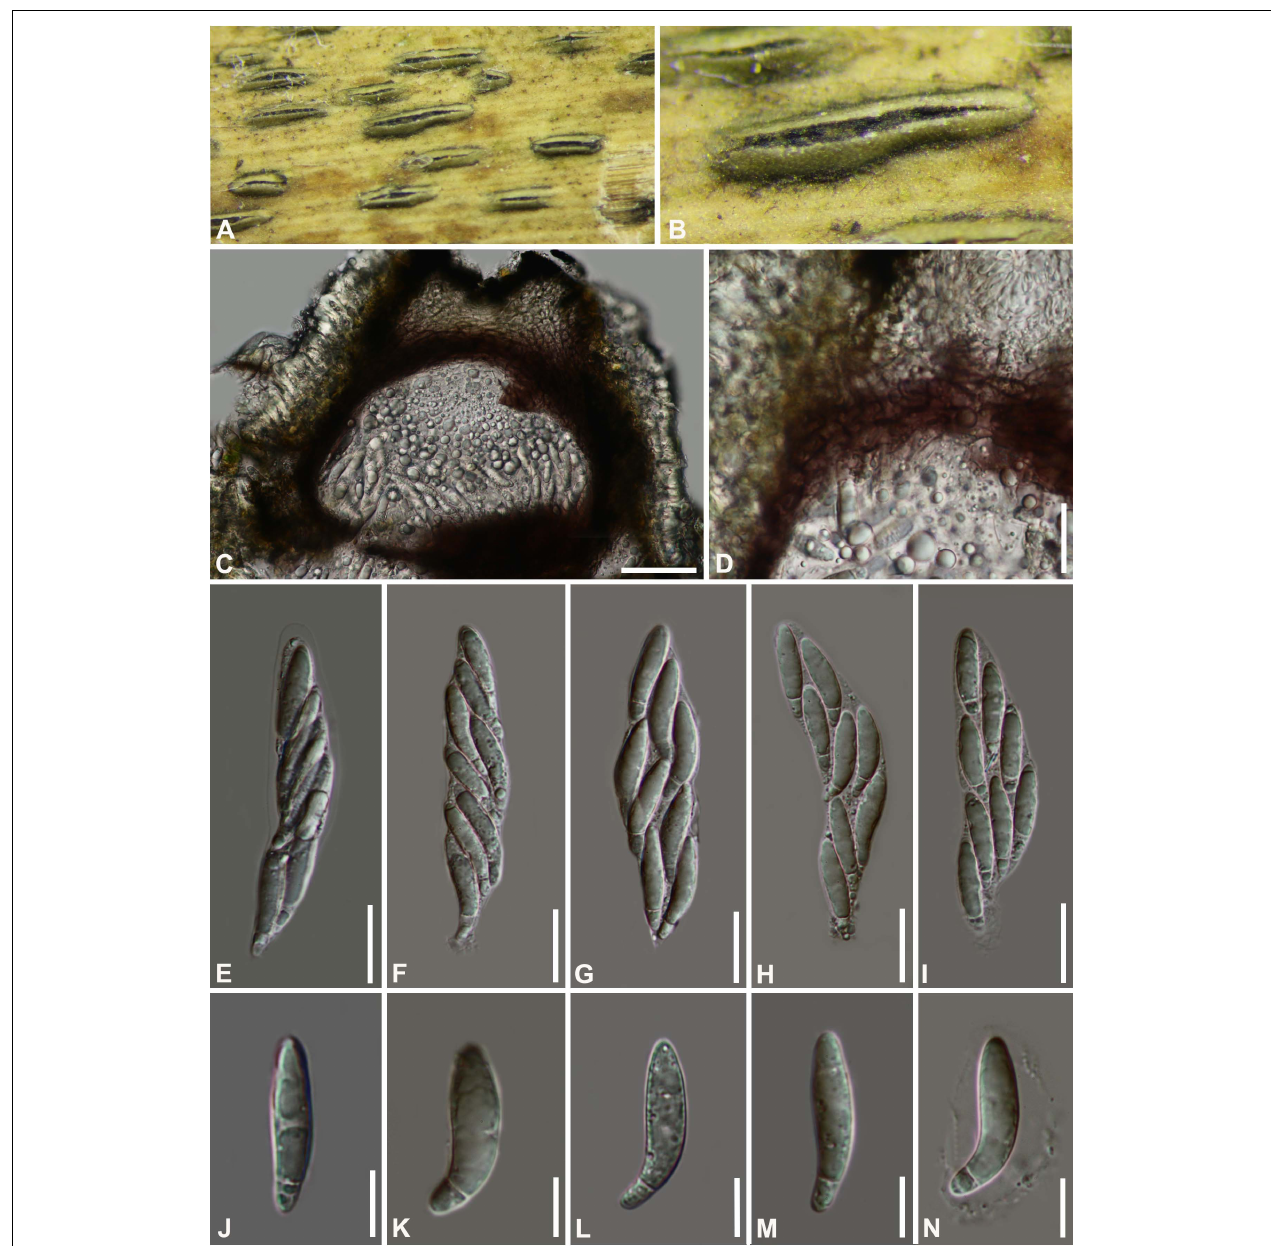
FIGURE 3 | Arthrinium gelatinosum ( HKAS 111962, holotype) . (A,B) Appearance of stromata on bamboo host. (C) Vertical section of stroma. (D) Peridium. (E–I) Asci. (J–N) Ascospore. Scale bars: (C) = 50 µ m. (D–I) = 20 µ m. (J–N) = 10 µ m.